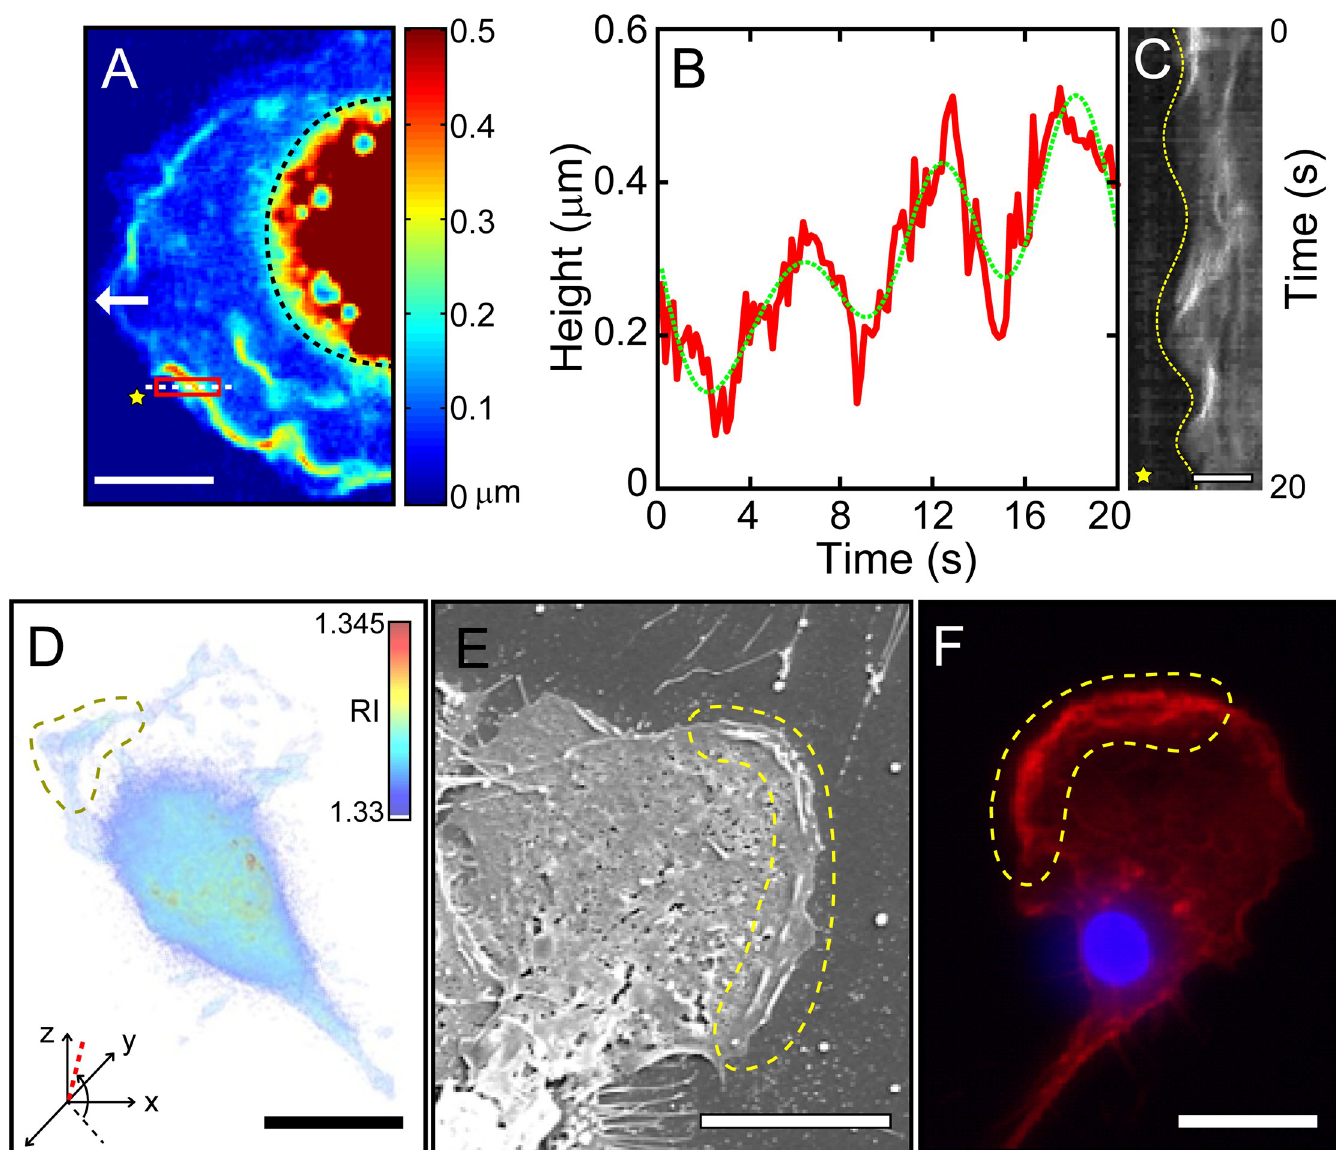
Fig 2. Peripheral ruffles waves of crawling microglia cells visualized by three different imaging modalities. (A) SAM phase image of peripheral ruffles in living microglia obtained by a QPI technique. The processed image is a heat map of the height of the dorsal surface of a MG cell from the substrate (white arrow: moving direction; black dotted line marks the core area; see Visualization 2 for their spatiotemporal evolution). (B) Averaged height (of the red-boxed area in (A)) vs. time, showing periodic nature of ruffle waves (the green dotted line is a boxcar-filtered (over 10 points) trace. (C) Kymograph showing spatiotemporal evolution of a leading front alongside the oscillatory behavior of ruffle waves (the 1D space of the kymograph is taken along the white dotted line in (A); the yellow dotted line traces the position of the leading front; and the yellow star marks the space outside the cell). (D) Isosurface image of 3-D RI tomogram (see Visualization 3). The bounded area by yellow dotted line is where peripheral ruffle wave dynamics are active (the tomogram viewing direction is indicated by a red dotted line in the x-y-z coordinate system with the viewing angles, -137˚ (azimuth) and 84˚ (elevation)). (E) SEM image of a fixed microglia showing the existence of ruffle waves at the leading edge (in the region bounded by yellow dotted line). (F) Epi-fluorescence image of a fluorescence stained (fixed) microglia showing F-actin (red) and core nucleus (blue, DAPI). Scale bars in A), C), D), E) and F) are 10, 5, 20, 10, 20 μ m, respectively.